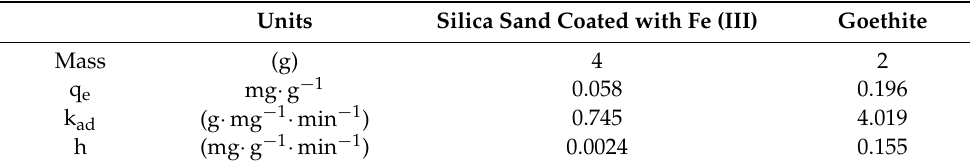
Figure 6. Kinetic sorption of As(V) for goethite.